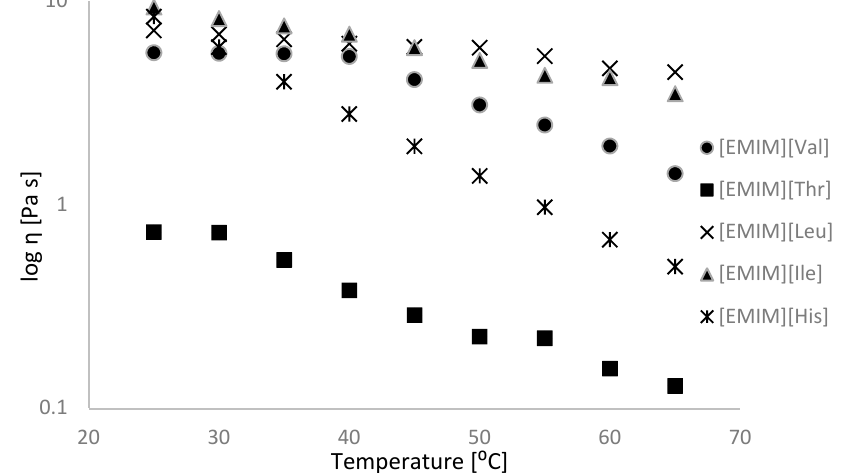
Figure 4. Variation in the viscosities of the 1-ethyl-3-methylimidazolium AAILs with temperature.